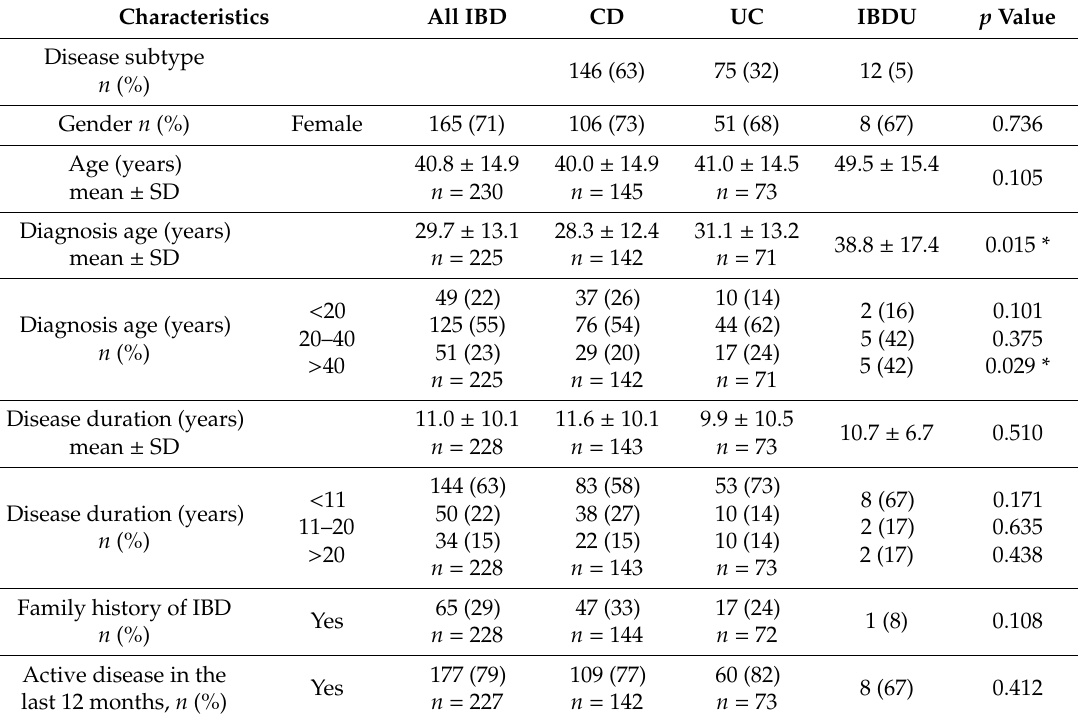
Table 1. Characteristics of 233